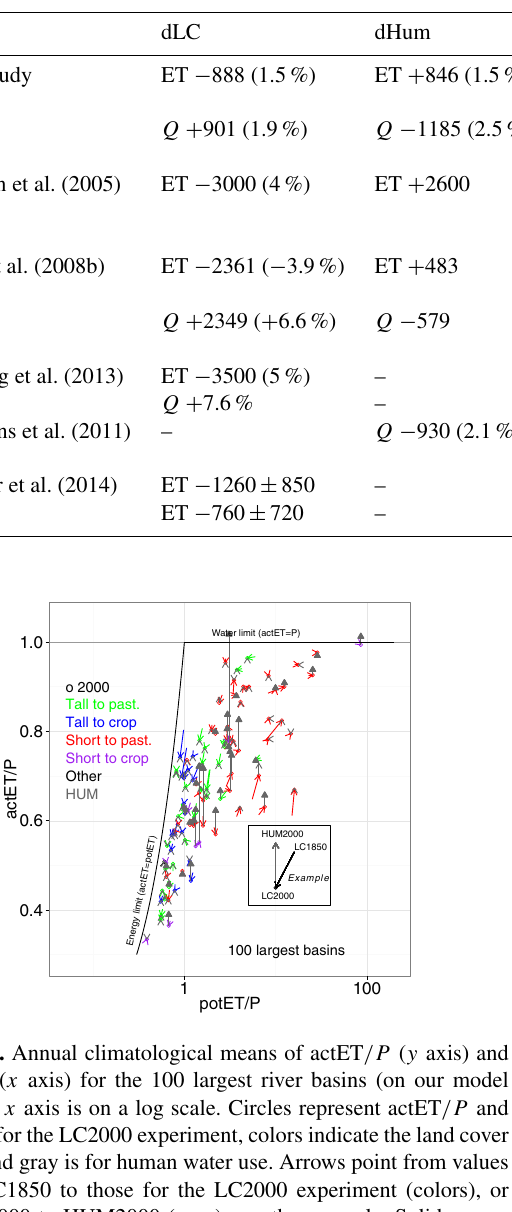
Table 5. Overview of studies assessing impacts of land cover change and/or human water use globally. Values given in cubic kilometers per year (km 3 yr − 1 ). See Discussion in Sect. 4.1.